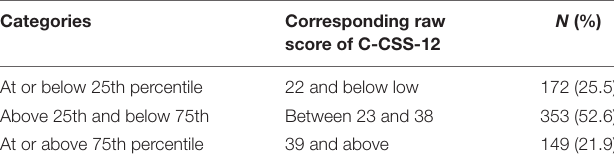
TABLE 2 | The distribution of C-CSS-12 scores of participants ( n =